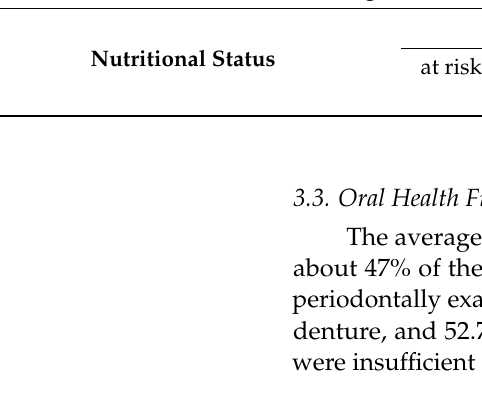
Table 3. Oral health of the participants and comparable data from the representative population in the fifth German Oral Health Study (DMS V)